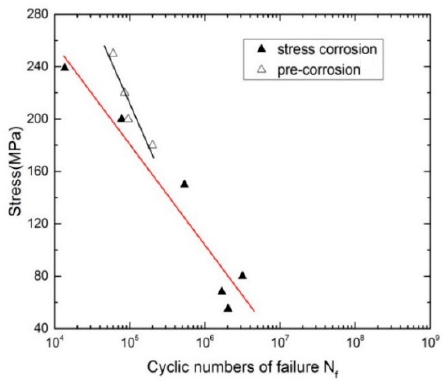
Figure 6. The S-N curves of AA2024-CZ under the different corrosion modes at 3.5 wt. % NaCl aqueous solution, all data of mark ∆ come from